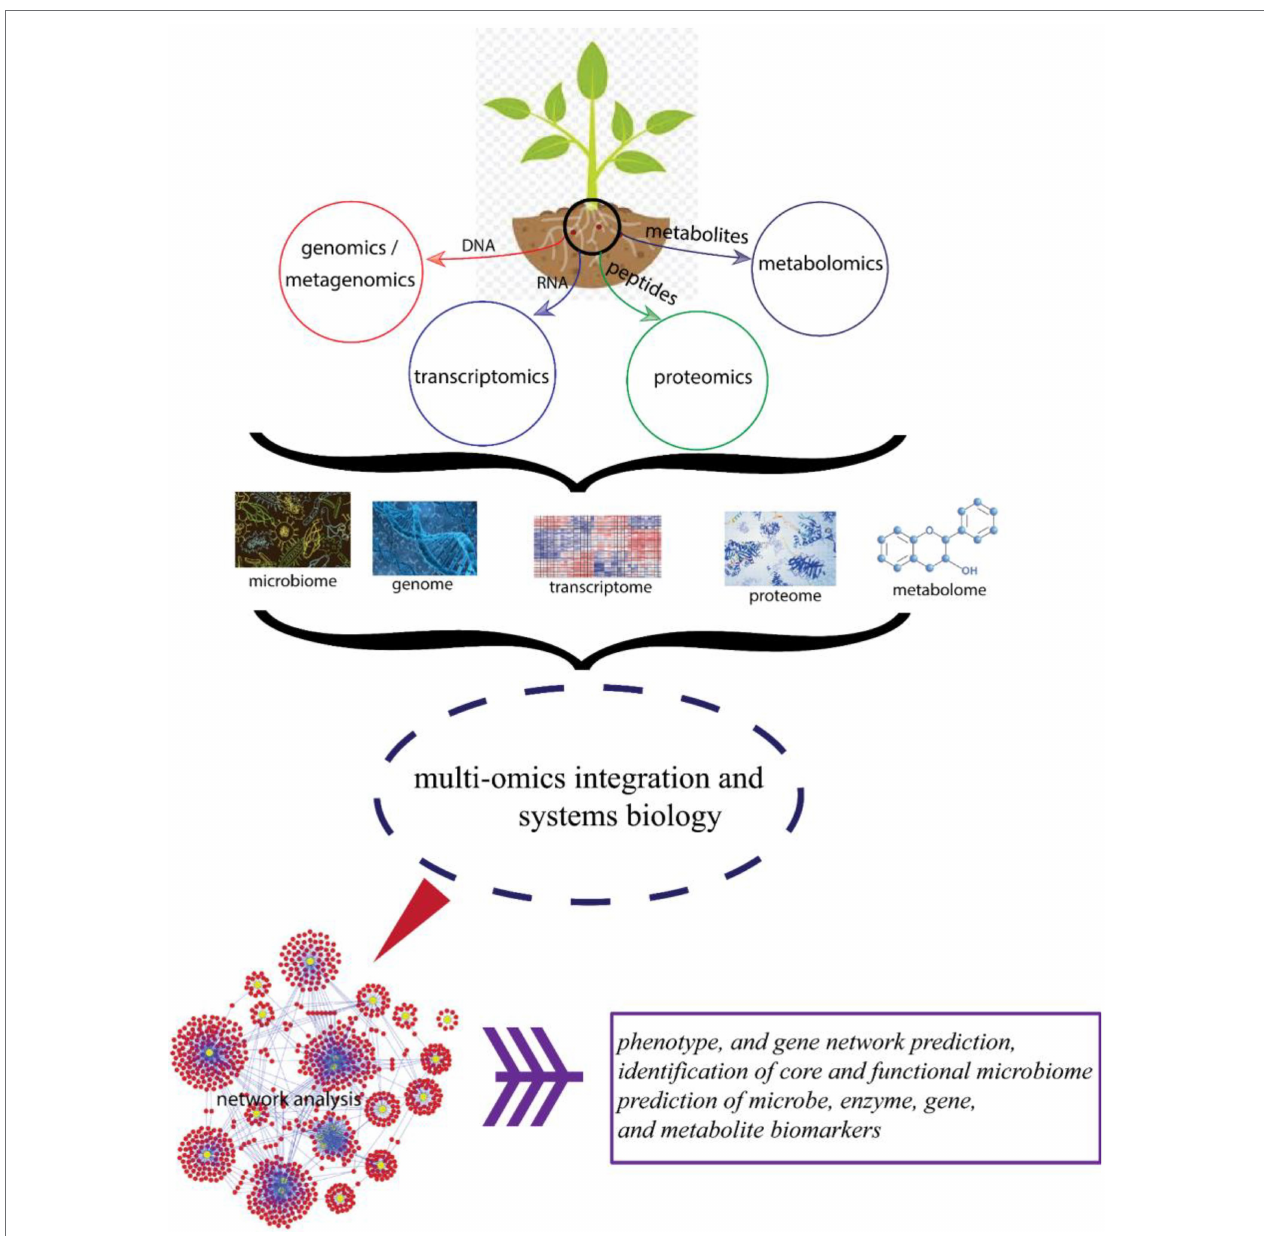
FIGURE 3 | Schematic diagram showing different omics approaches and their beneficial effects toward improved plant